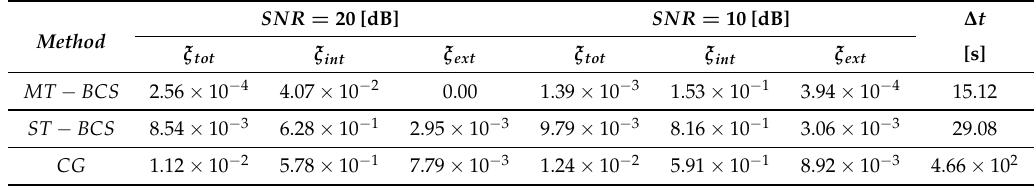
Table 3. Comparative Assessment ( K = 2, O = 6, τ = 2.0, SNR ∈ [ 10, 20 ] [dB])—Inversion performance